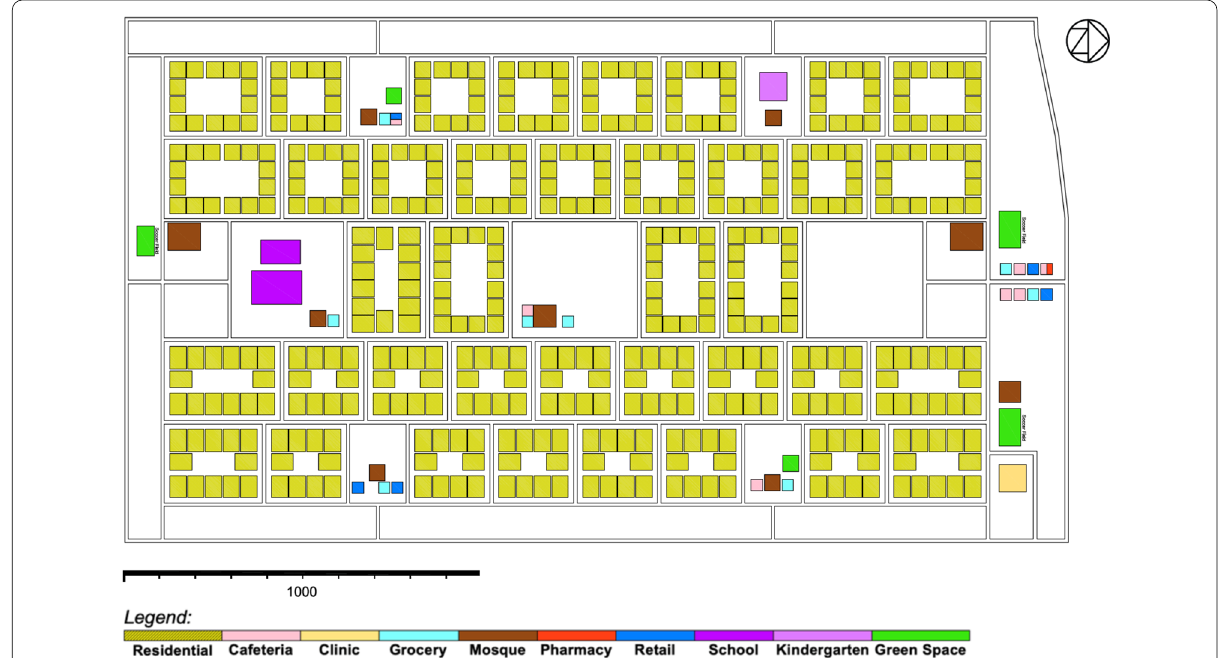
Fig. 5 Neighborhood N1: Al Dhaher, representing the sprawling urban morphology in the